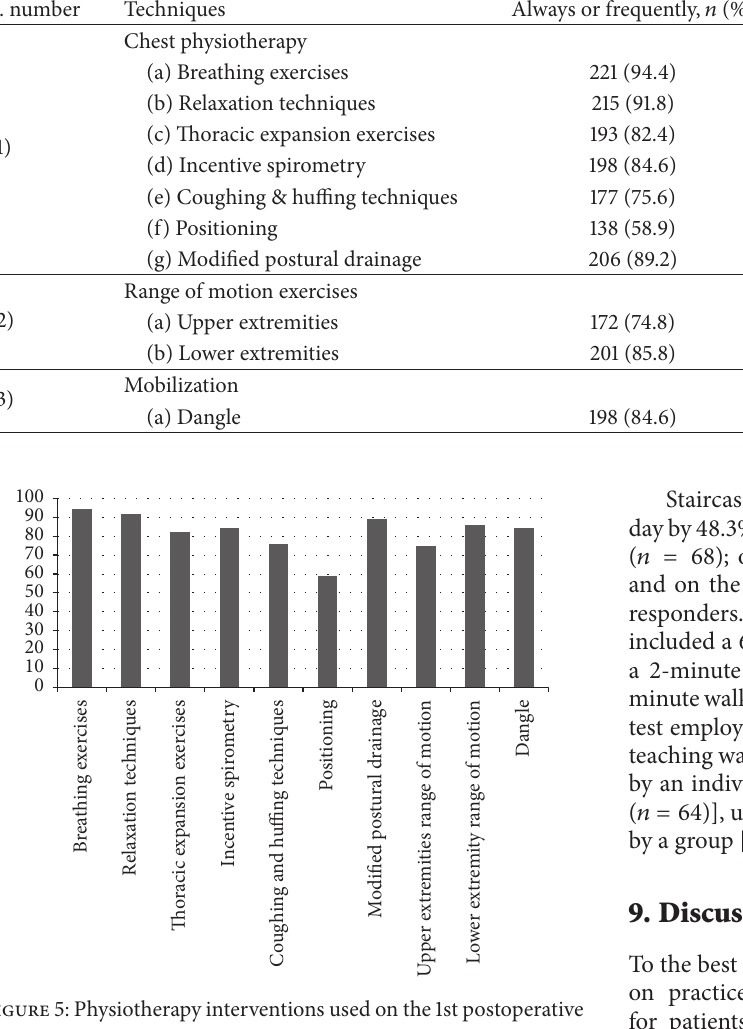
Table 5: Physiotherapy interventions used on the 1st postoperative day. S. number